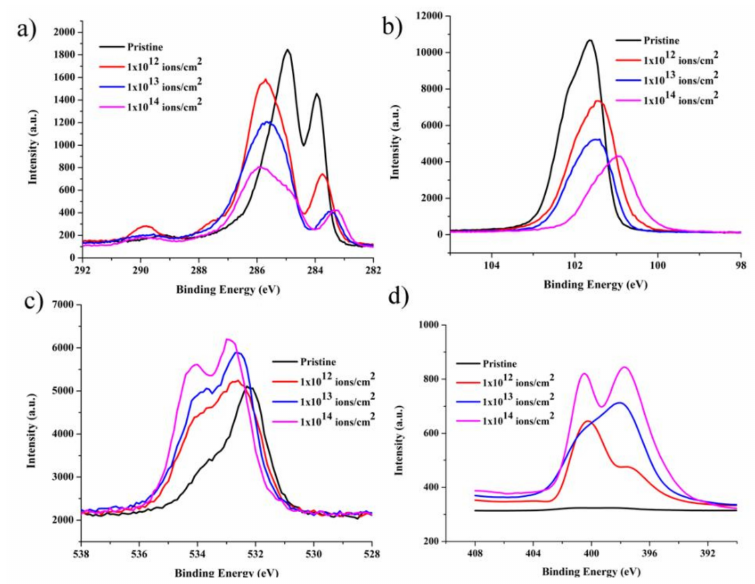
Figure 5. ( a ) C 1s; ( b ) Si 2p; ( c ) O 1s and ( d ) N 1s spectra obtained from XPS of pristine and N +